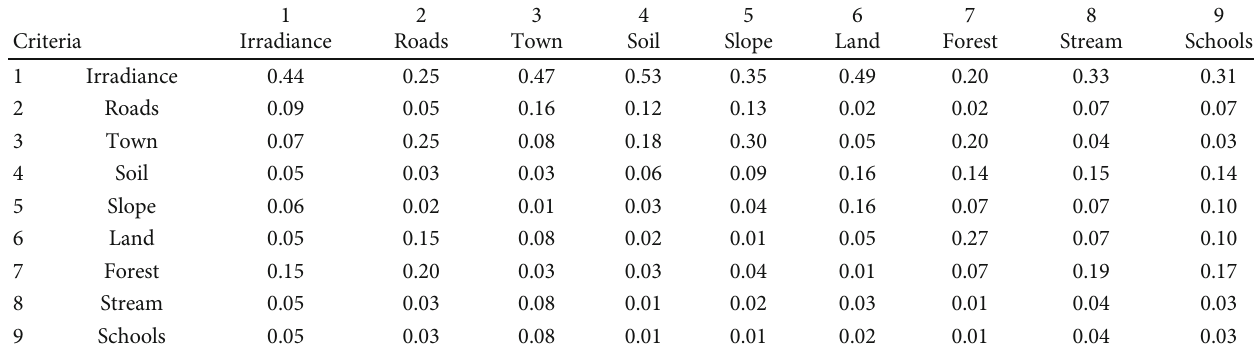
Table 5: Normalized decision matrix of a solar PV power plant.